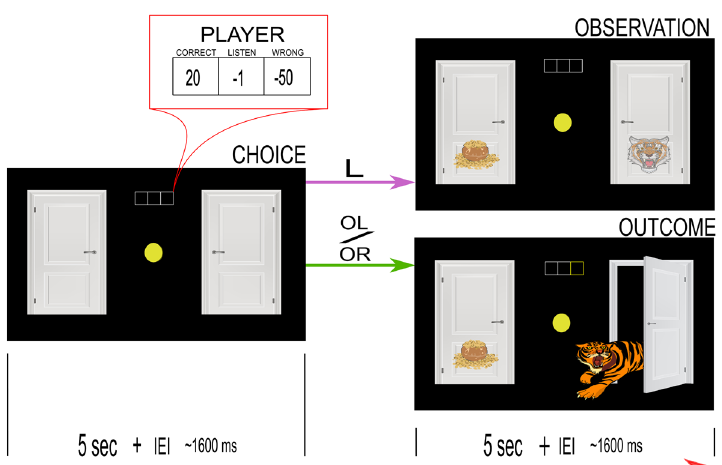
Figure 2. Task sequence of the single-agent version of the tiger task (TT). At the beginning of each decision step, the participant saw two doors and made an action choice (CHOICE) from a set of three actions (Listen (L), Open-left (OL), Open-right (OR)). Participants had 5 seconds to make their choice, else a default listen action was chosen for them. A chosen listen action led to a probabilistic observation (PHYSICAL-OBSERVATION, 70% correct), and the sequence repeated. The probabilistic hints were signified by semi-transparent images of the tiger and the gold-pot on the respective doors. There was always an inter-event-interval (IEI) of ∼ 1600 milliseconds. Choosing left/right open action opened the door (OUTCOME), where the participants either received the gold-pot or encountered the tiger (tiger encounter is shown here). Opening the door reset the tiger and the reward to begin the task sequence again. The matrix in the red box shows the potential payouts the participant could expect upon the different action choices (constantly displayed through the